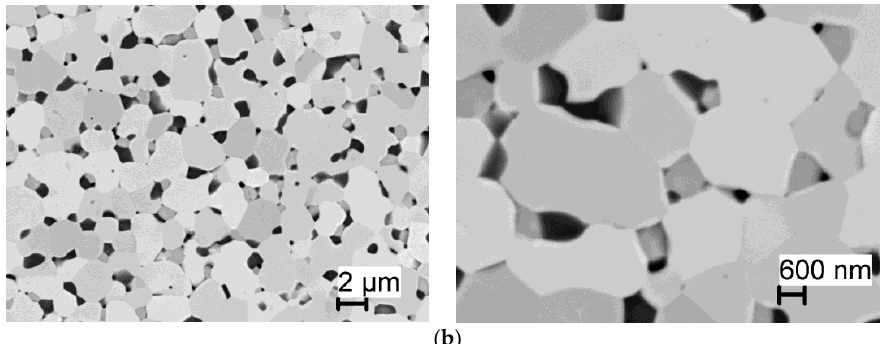
Figure 2. Microstructure of W-3Ti-2Hf and W-7Ti-2HfC consisting of W-Ti matrix (bright larger grains), (Ti,W,Hf)C (dark grains) and HfO 2 (HfTiO 4 ) particles (bright small grains). ( a ) W-3Ti-2Hf; ( b ) W-7Ti-2HfC.